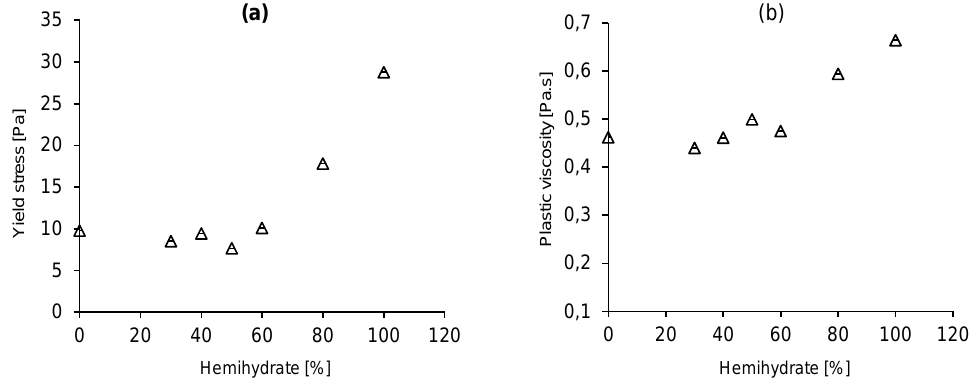
Figure 2: Effect of hemihydrate fraction among the total calcium-sulfate bearing materials on (a) yield stress and (b) plastic viscosity.